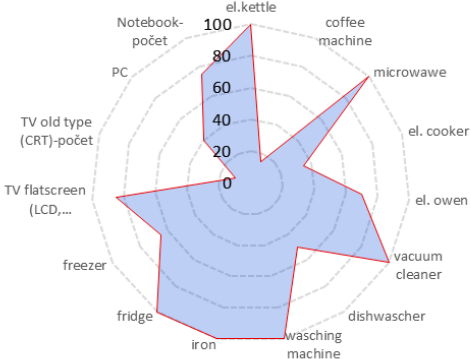
Table 1. Survey main questions.